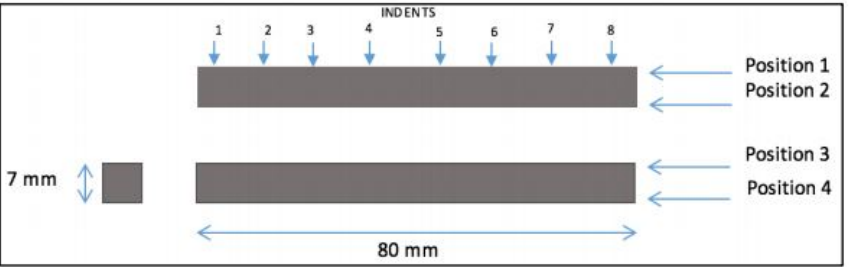
Figure 20. Details of different paths and the positions of indentations in the microhardness test.